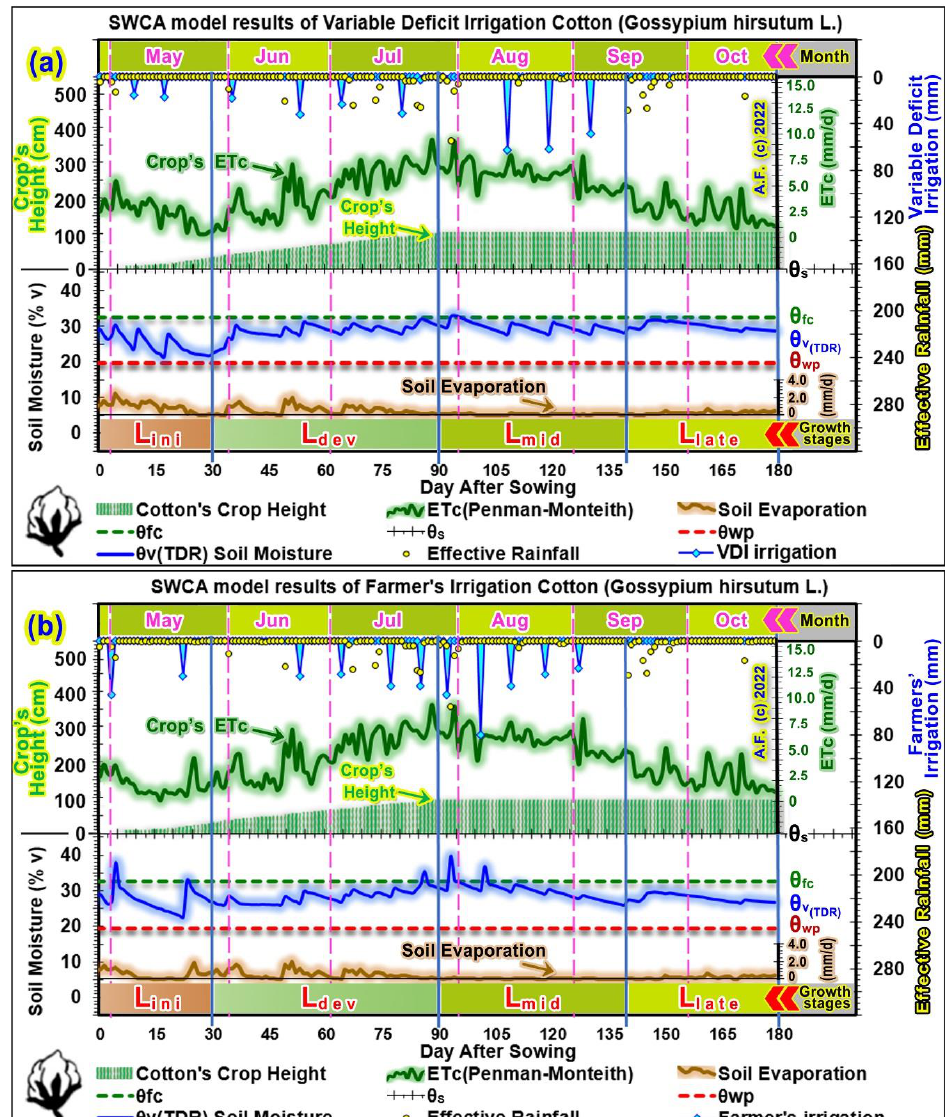
Figure 5. The daily soil–water–crop–atmosphere model results and the soil moisture measurement results for the four cotton growth stages of: ( a ) IR1:VDI-2 irrigation treatment and ( b ) treatment for IR2:FI-2 f armers’ common irrigation practice s.